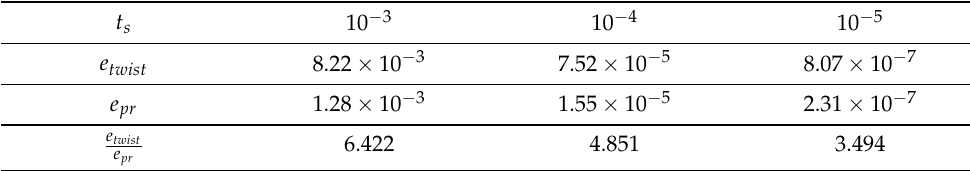
Table 4. The simulation results with different integration